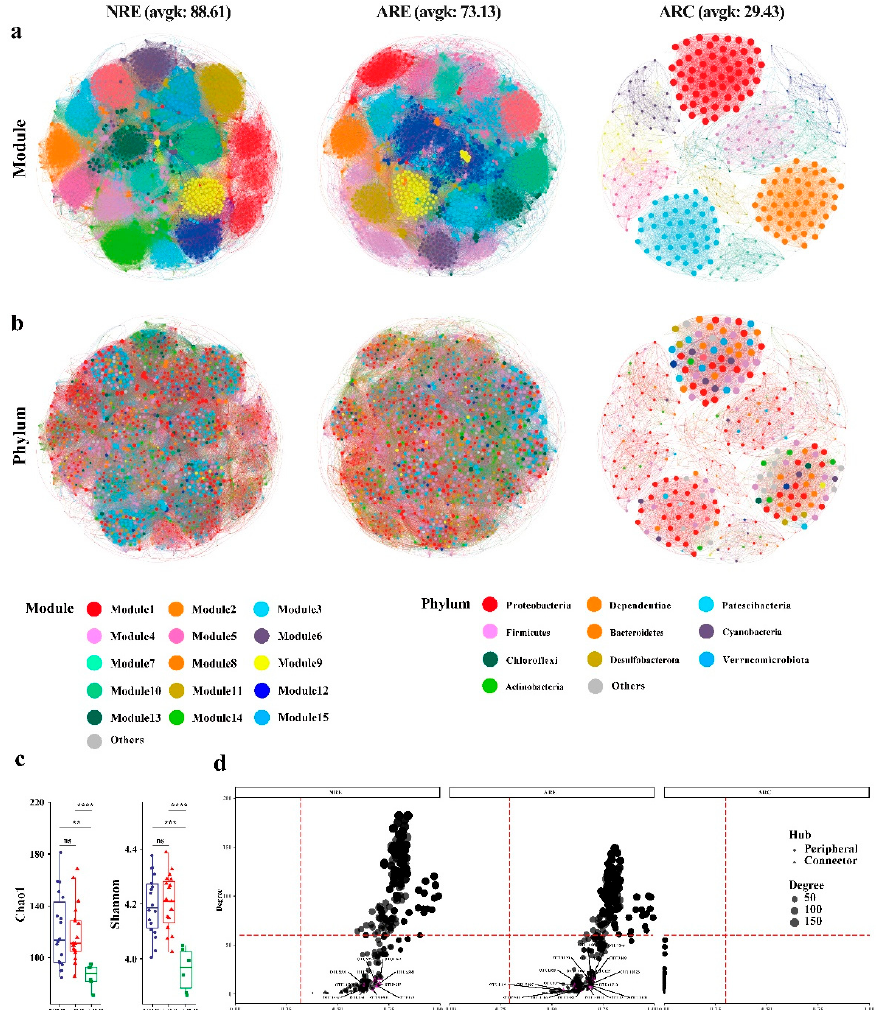
Figure 6. Topological roles of microbial co-occurrence subnetwork. ( a ) Different colors repre- sent different modules from three subnetworks. ( b ) Different colors represent different phyla from three subnetworks. ( c ) The asterisks represent the statistically significantly different values. **: p < 0.01, ***: p < 0.001. ( d ) The relationship between the degree and closeness centrality under three